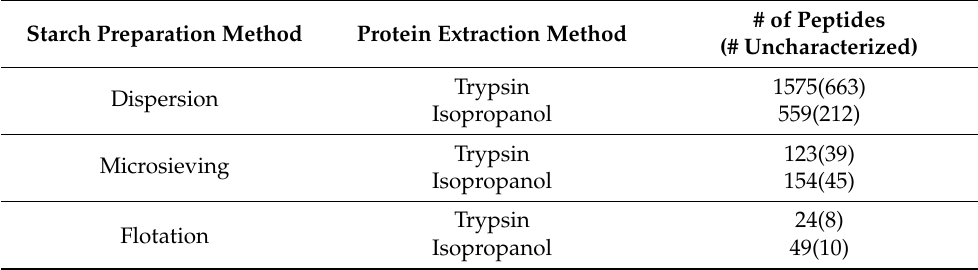
Table 1. Number of peptides identified by mass spectrometric